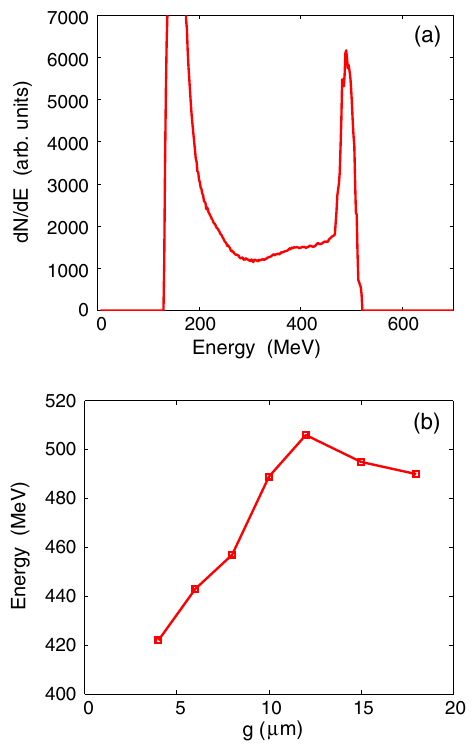
FIG. 4. (a) Spectrum of the TNSA protons behind the target at t ¼ 200 T for g ¼ 10 λ the width of the transverse density profile of the preplasma. (b)Peak proton energy versus g